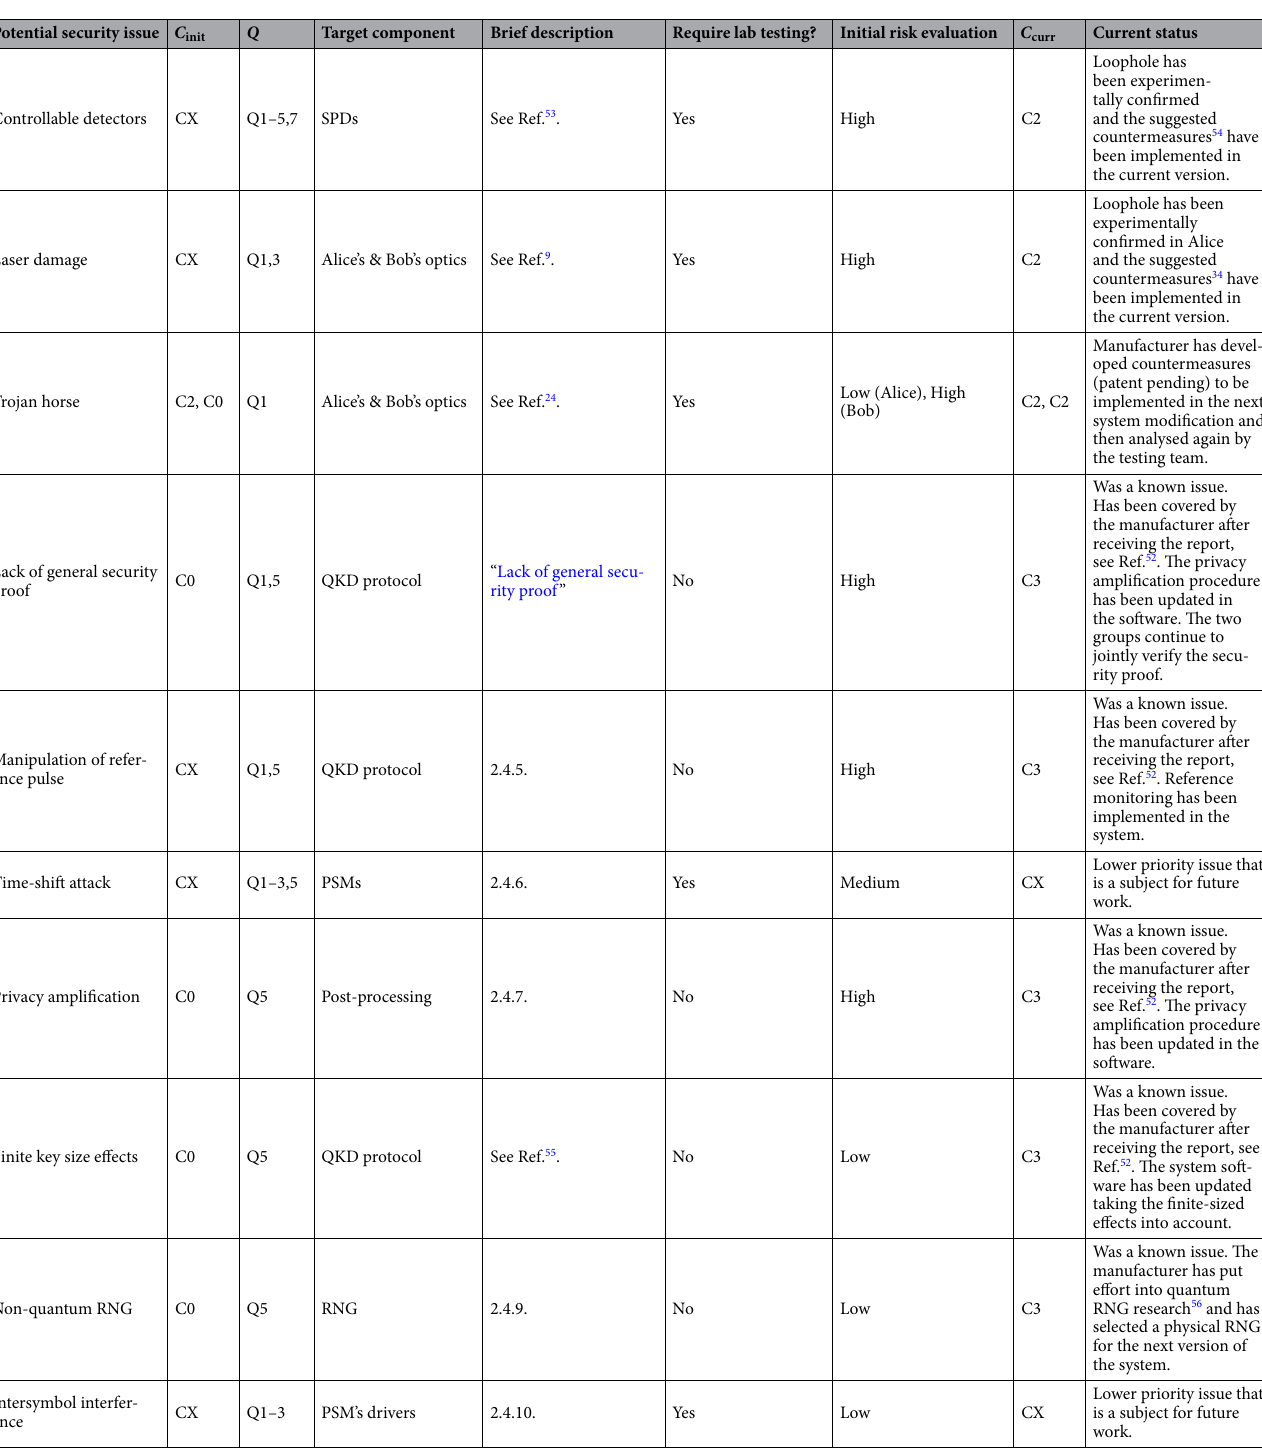
Table 3. Summary of potential security issues in ITMO’s subcarrier-wave QKD system. C init ,